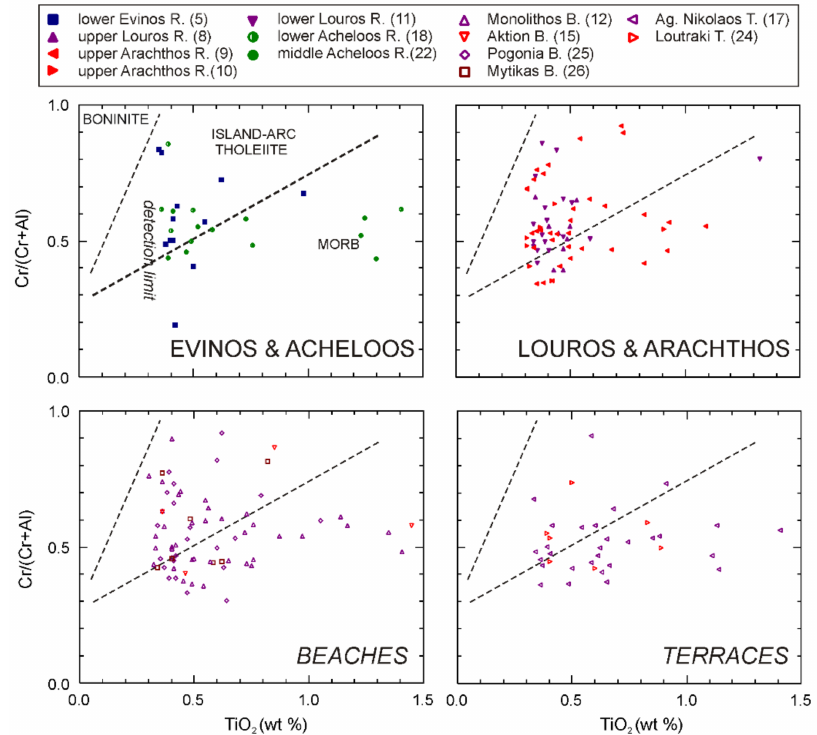
Figure 8. Titania content of chromite and spinel. Fields from [47] show characteristic sources in different types of